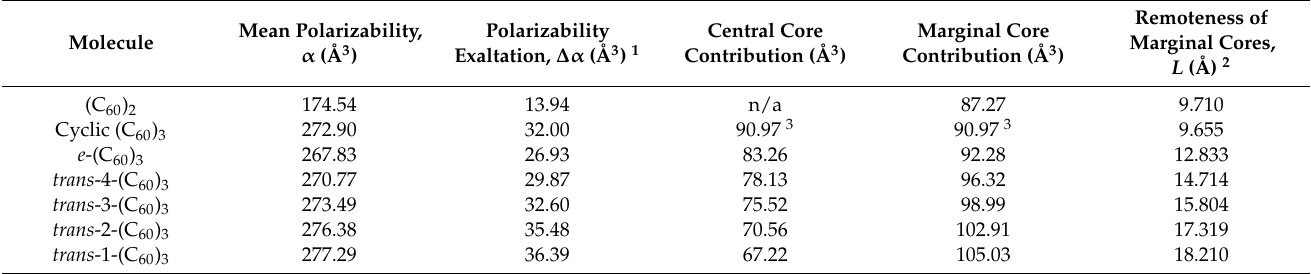
Table 1. The TPSS/TZVP-calculated polarizability and structural parameters of (C 60 ) 2 and (C 60 ) 3 .